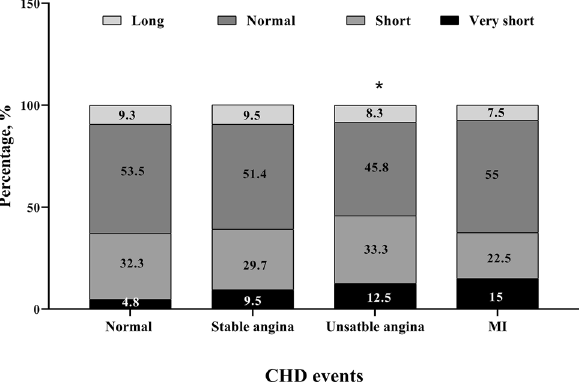
Figure 1. Prevalence of CHD events according to nightly sleep; *p <